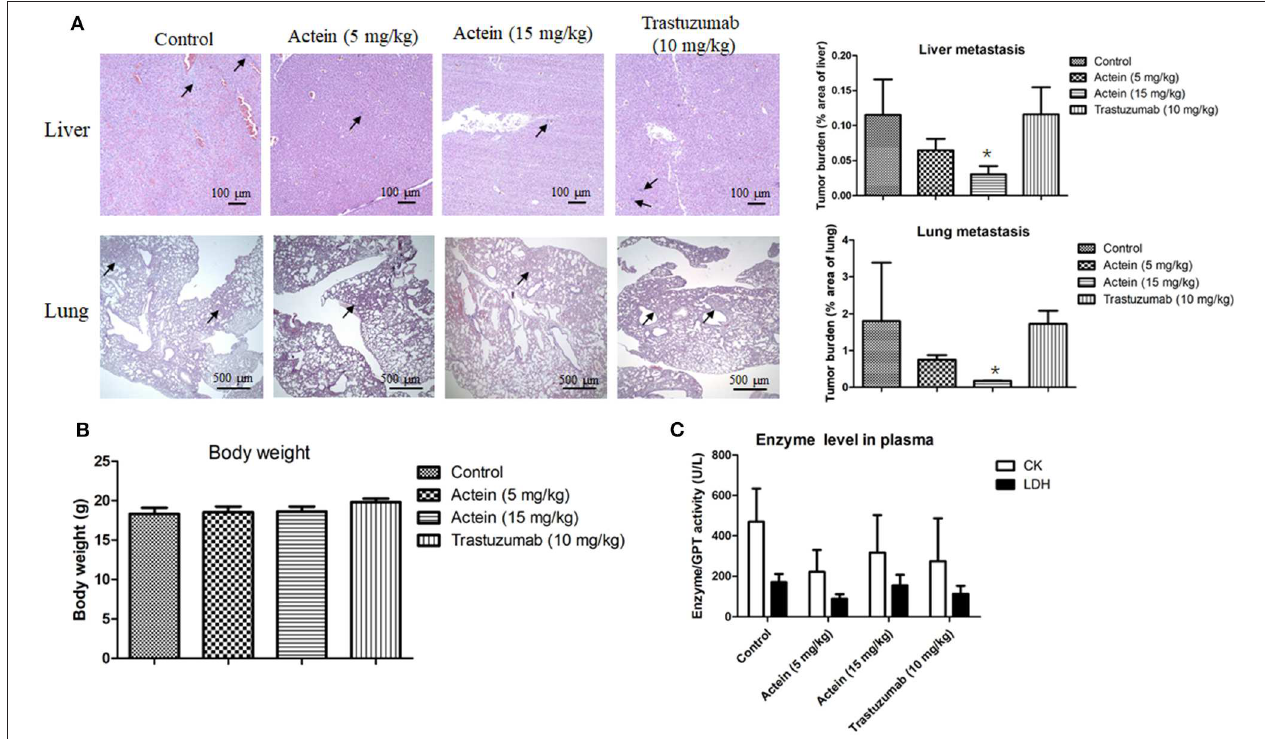
FIGURE 5 | Histopathology of lungs and livers of tumor-bearing mice after actein oral administration. (A) The paraffin-embedded sections of the lungs and livers were photographed and used to measure metastatic loci area and total lung or liver area. The histograms showed the tumor burden in lungs and livers according to the tumor area as a percentage of whole lung or liver area per group. Representative H&E-stained sections of lungs and livers from different groups with arrows showing the metastatic loci. Results were expressed as mean + SD of 12 mice each group. (B) The final body weights of mice before sacrifice. (C) Plasma enzyme activities of LDH and CK were calculated at the end of the experiment. Differences among the treated and vehicle treated control groups were determined by One-way ANOVA. * p < 0.05 as compared to control